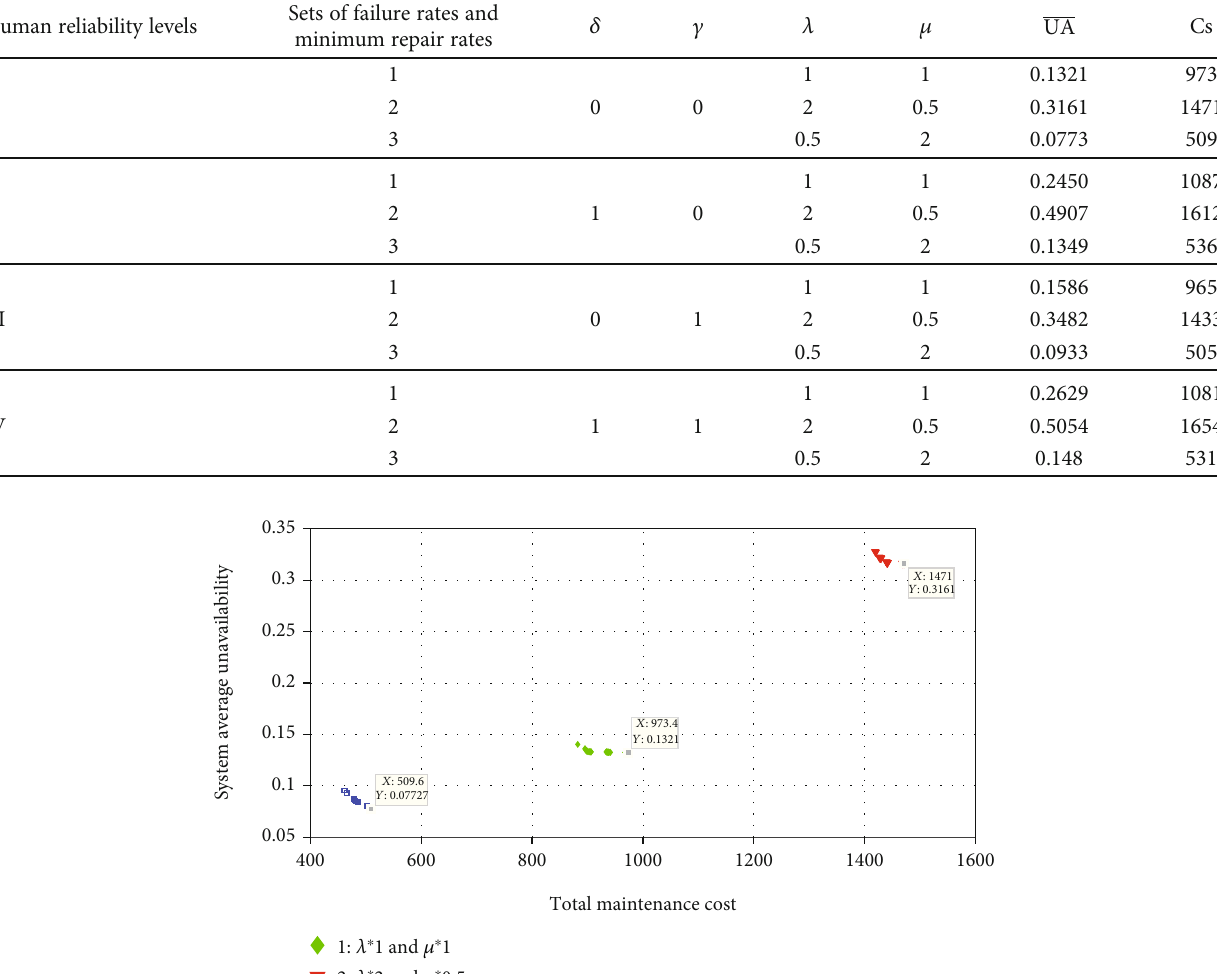
Table 6: DOE scheme and experimental results.